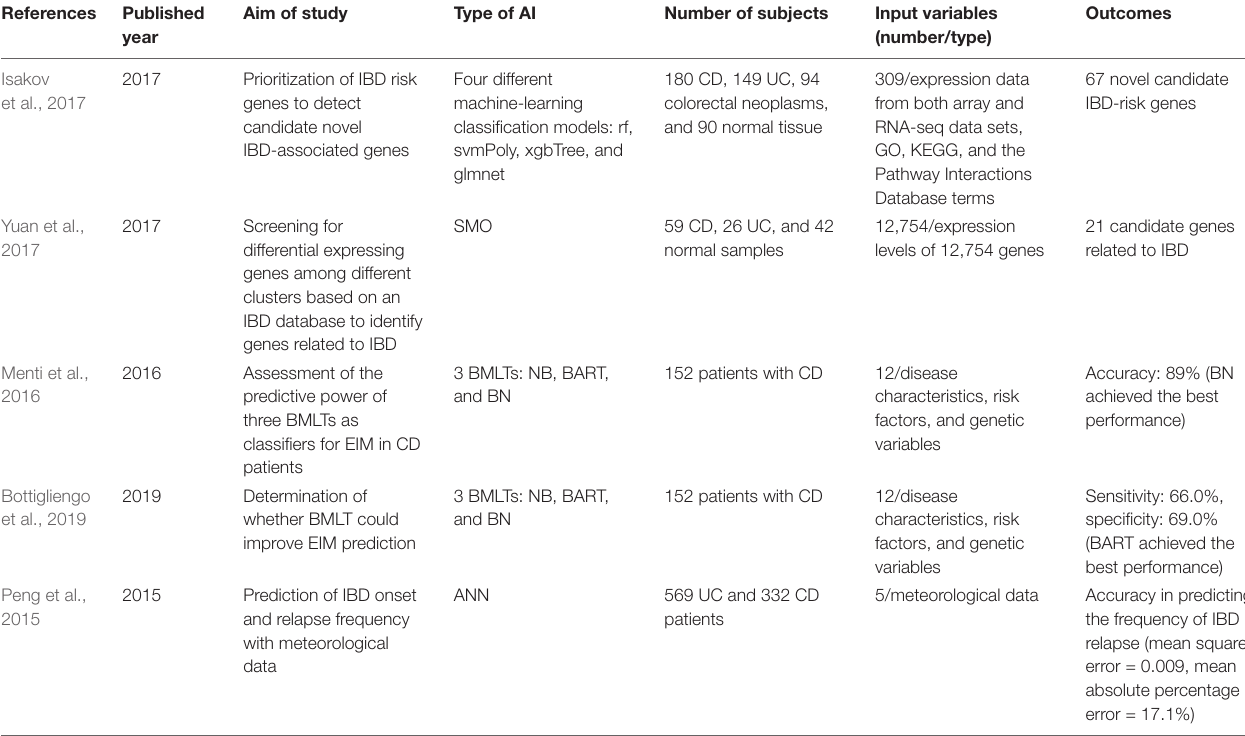
TABLE 1 | Summary of studies using artificial intelligence in IBD